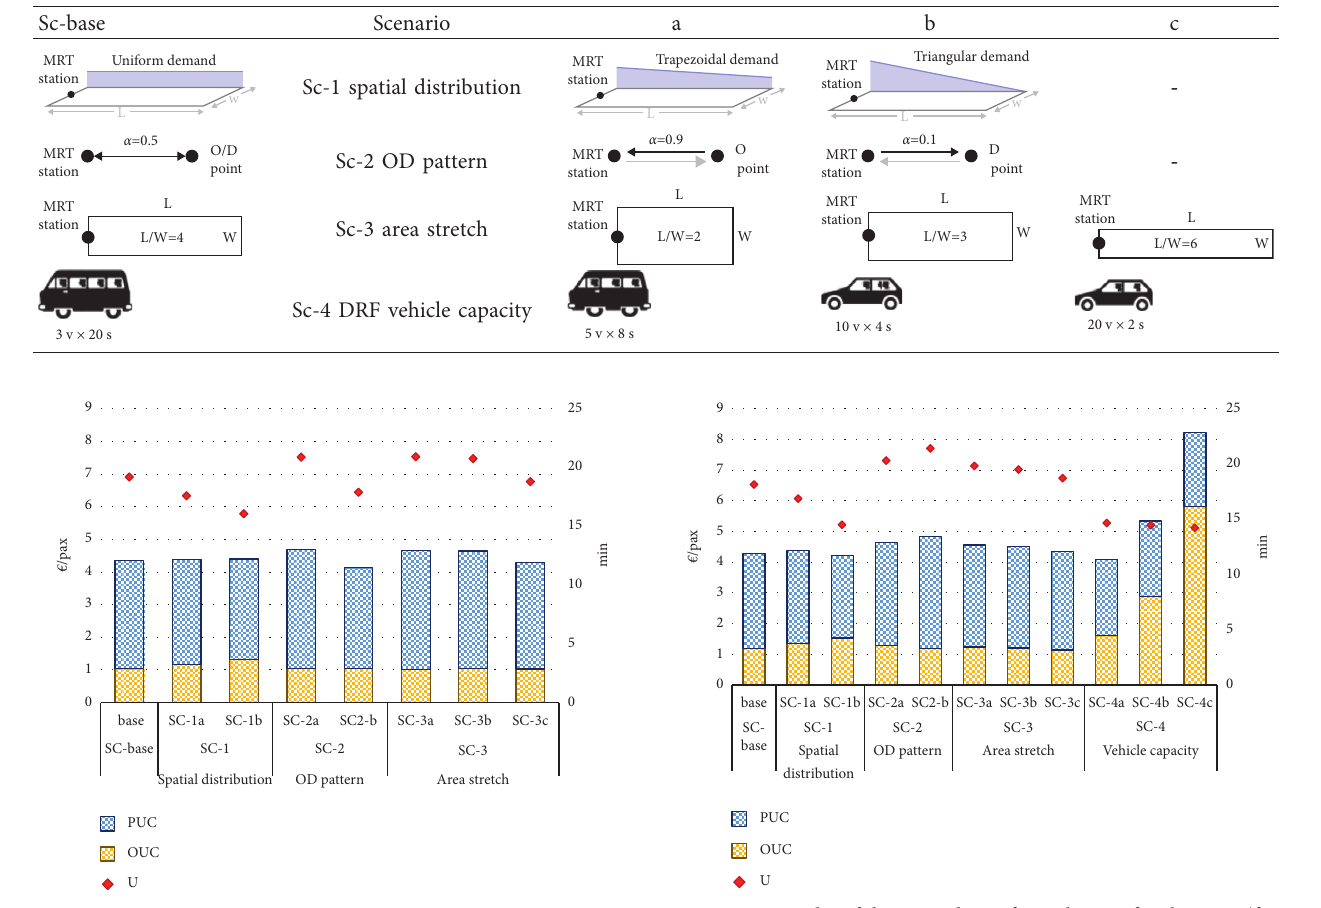
Table 4: Description of the second set of simulated scenarios.